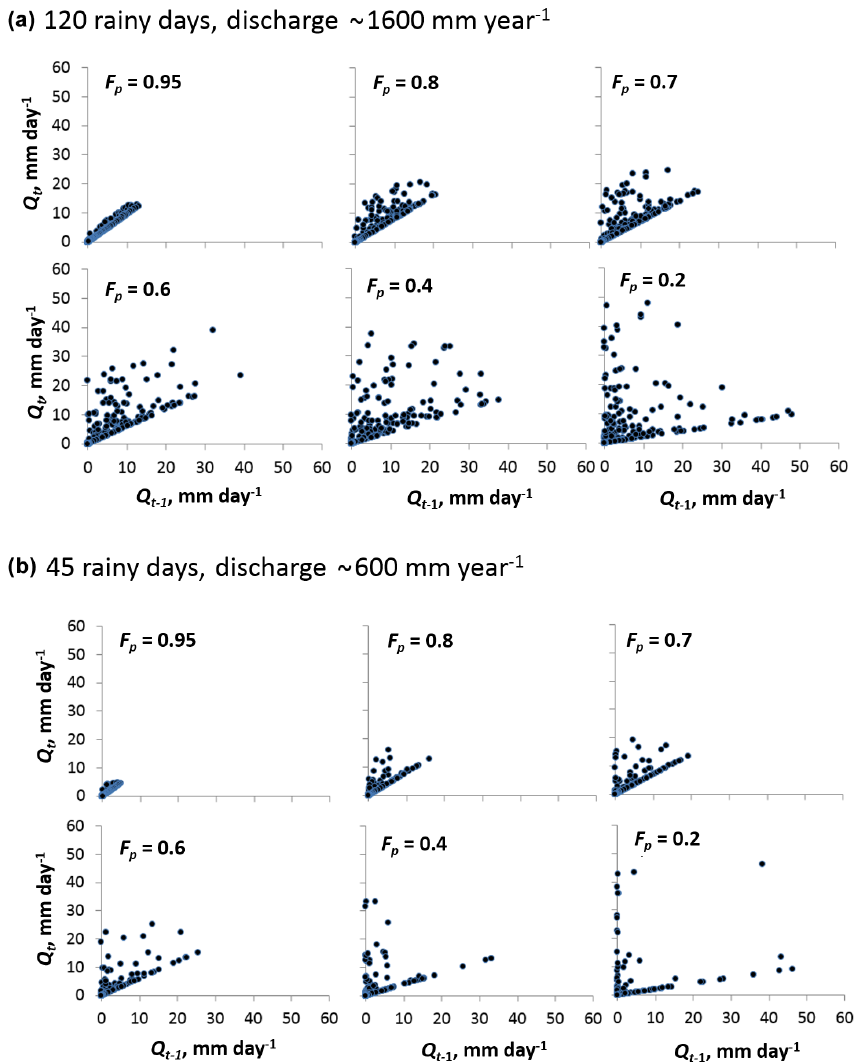
Figure 5. Panels (a) and (b) show the temporal autocorrelation of river flow for the same simulations as Fig. 4; the lower envelope of the points indicated slope F p , the points above this line the effect of fresh additions to river